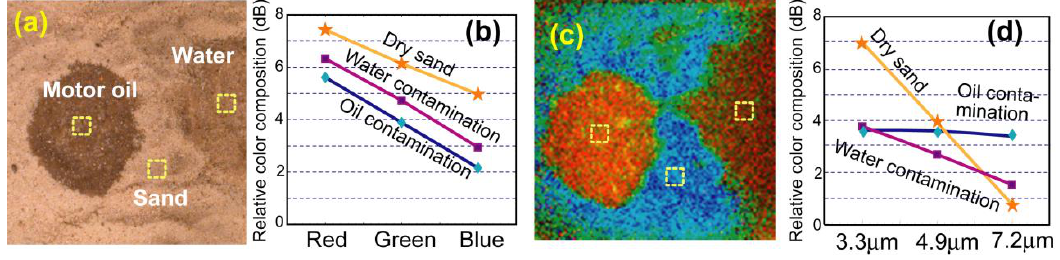
Figure 7. (a) Visible image of sand contaminated with oil and water. (b) RGB colorimetric decompositions of spots marked by dashed yellow square boxes in (a), which shows that the appearance difference between the three marked spots is not spectral (color) but only of intensity (lightness). (c) The M/LWIR multi-spectral false color image makes clear spectral discrimination and not just intensity discrimination between the spots. The reason is shown in (d): they have distinctive M/LWIR